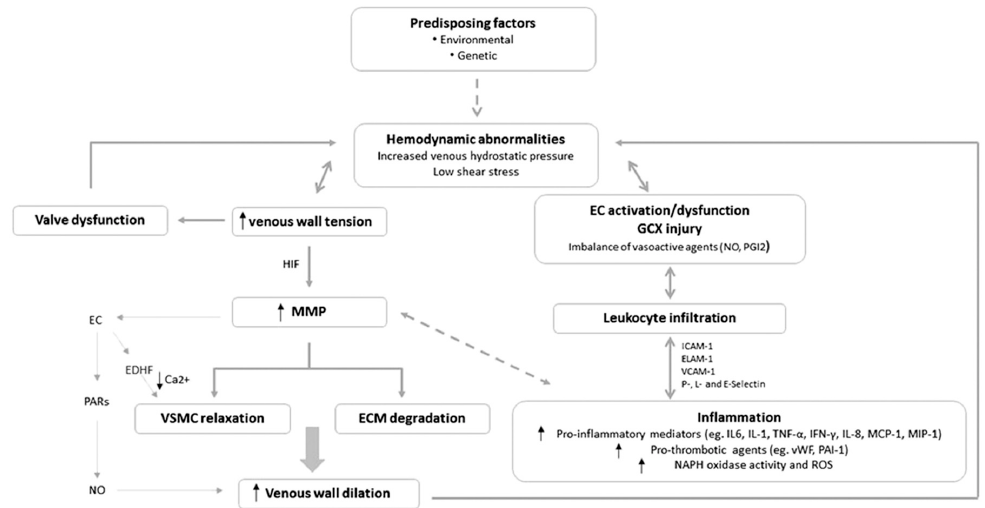
Figure 1. Schematic representation of the interplay of the pathophysiological mechanisms contributing to CVD development. Predisposing factors such as female sex, pregnancy, family history, obesity, sedentary lifestyles and occupations can lead to hemodynamic abnormalities in the veins of the lower legs,